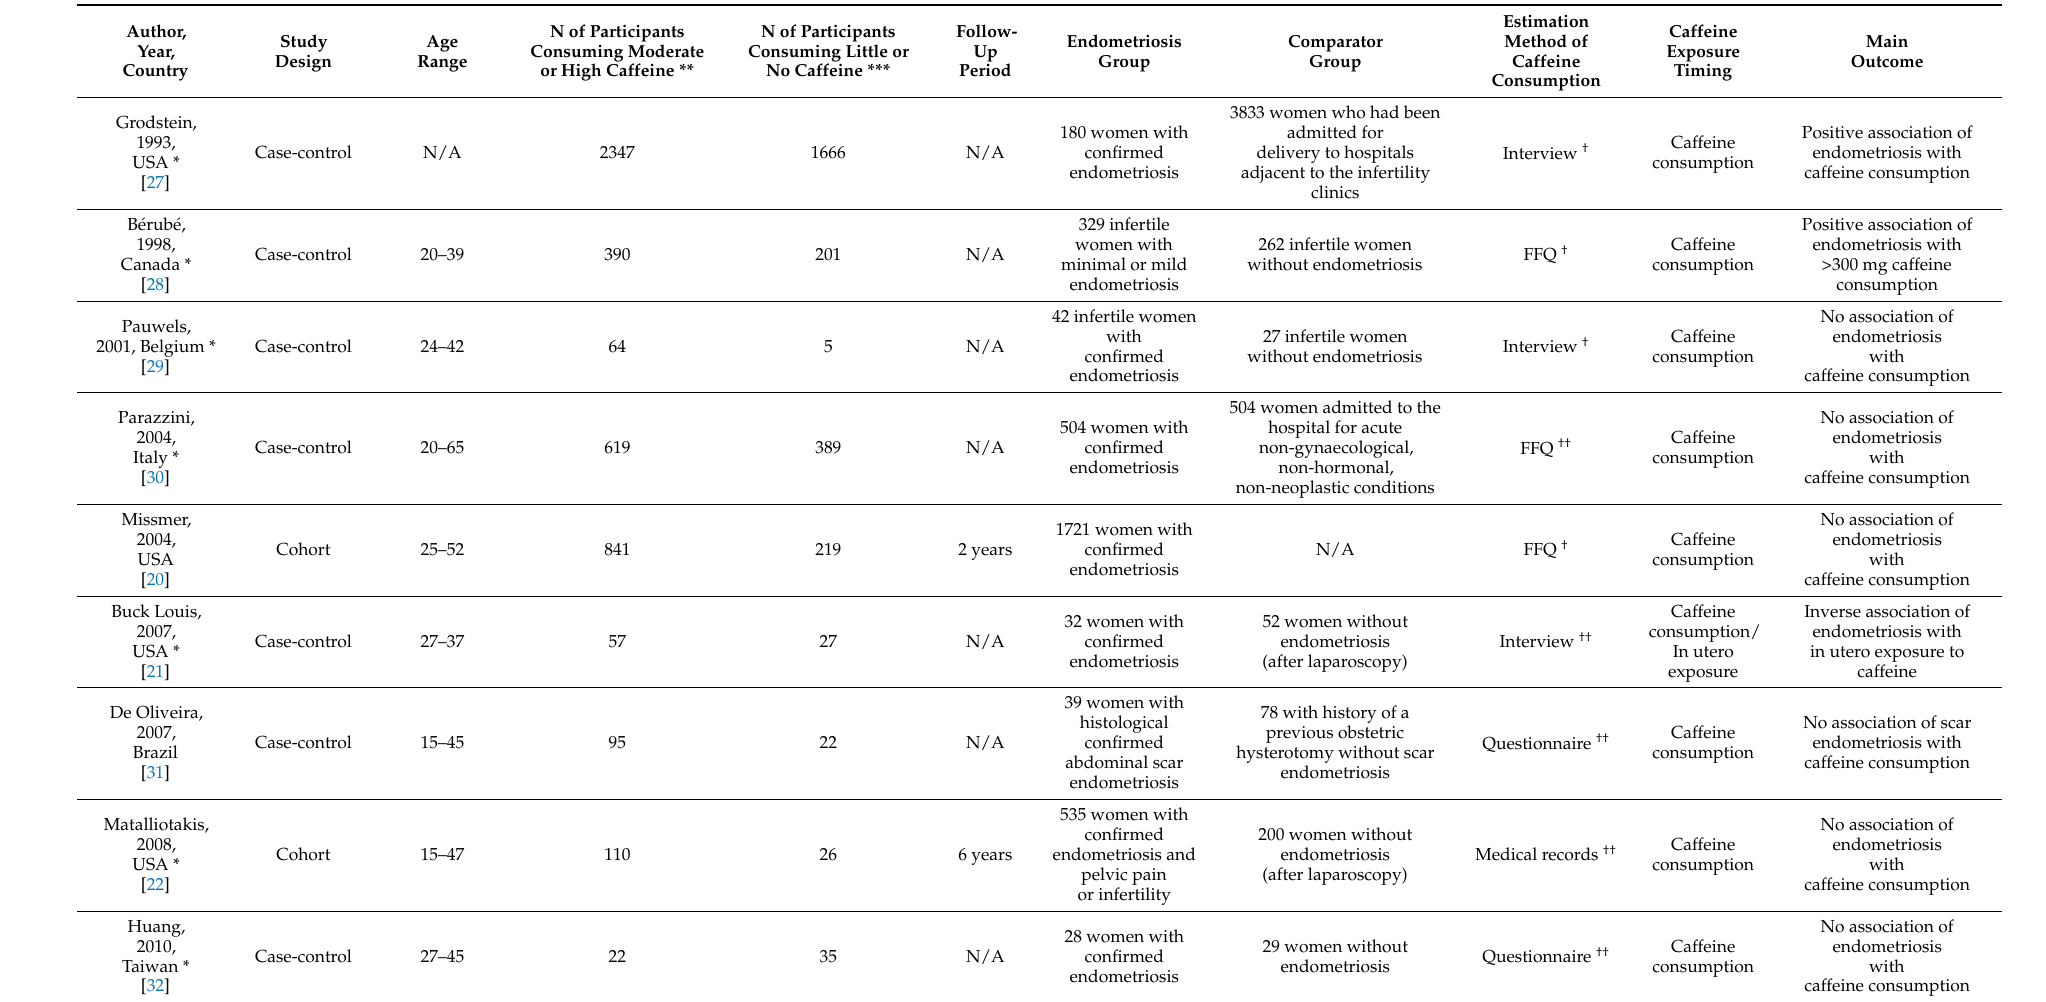
Table 1. Characteristics of the included